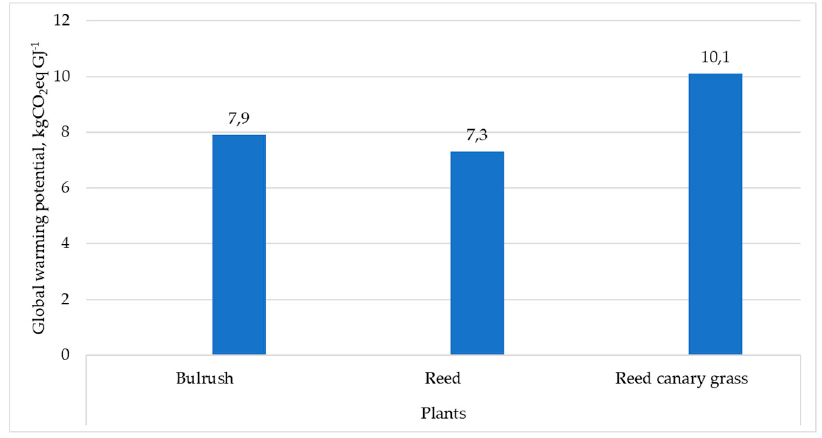
Figure 4. Global warming potential of reed plant pellets, including biomass extraction, transportation, processing, and final product preparation.